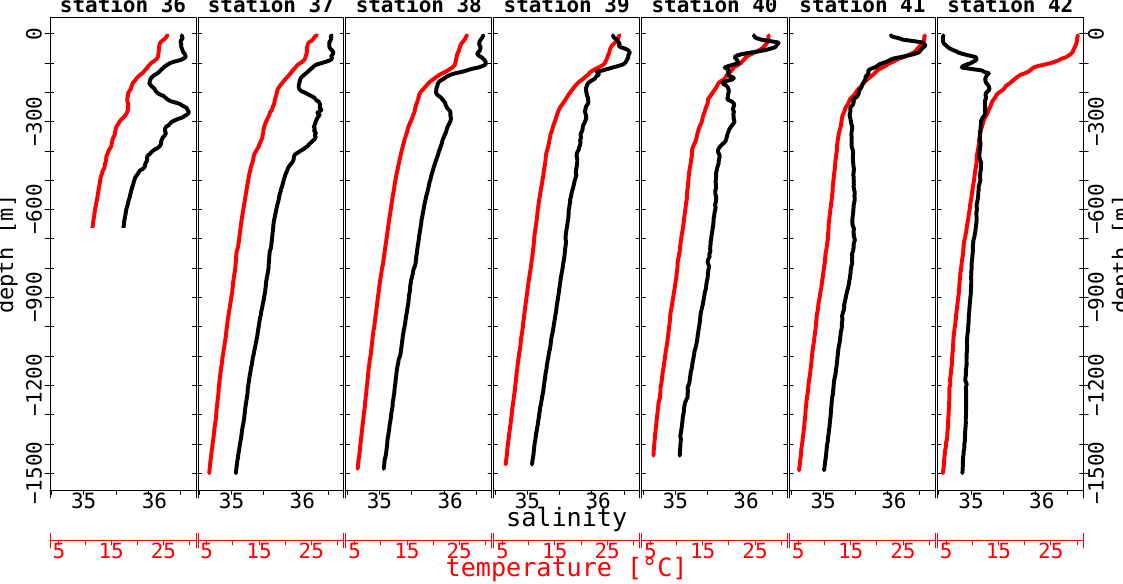
Figure 2. Vertical profiles of salinity (black curves) and temperature (red